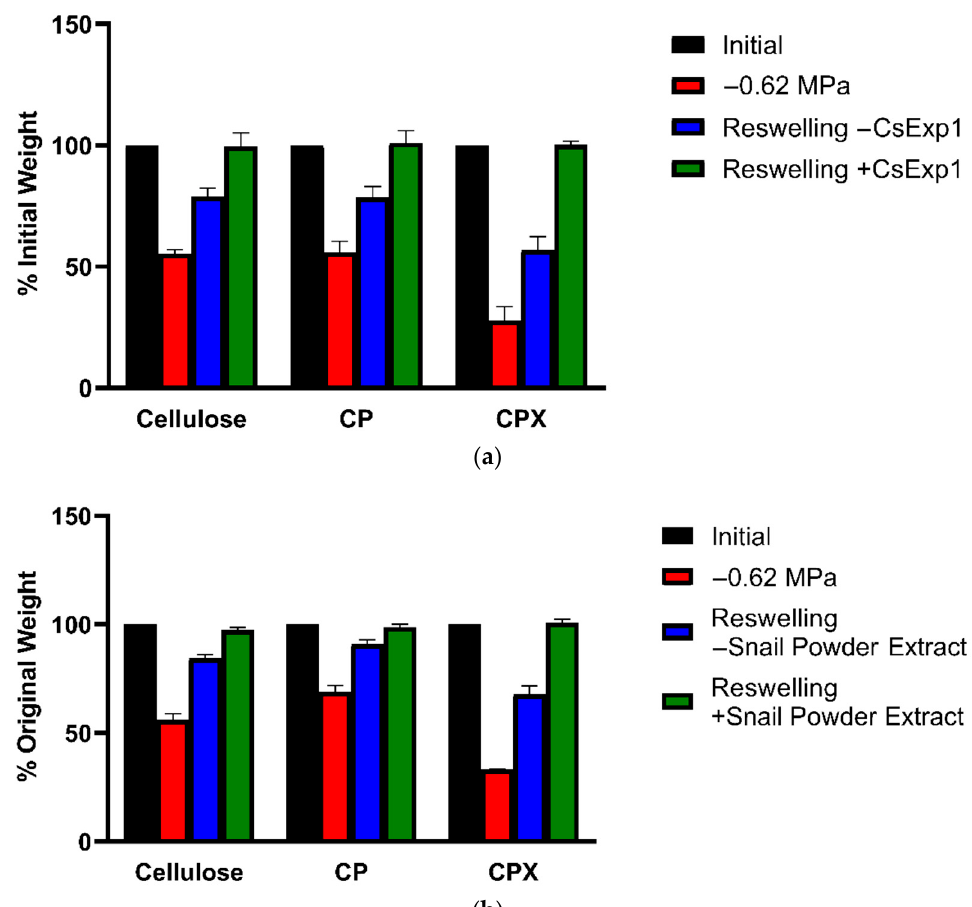
Figure 3. Summary of changes in hydration in pieces of bacterial cellulose, bacterial cellulose composite with apple pectin (CP), and bacterial cellulose composite with apple pectin and xyloglucan (CPX) as a percentage of initial weight (black fill), after 180 min at − 0.62 MPa (red fill), after 120 min in control buffer (blue fill), and after treatment with 11.2 μ g of α -expansin (green fill in ( a )) or 200 μ L of snail powder extract (green fill in ( b )). Error bars indicate S.D. ( n = 3).